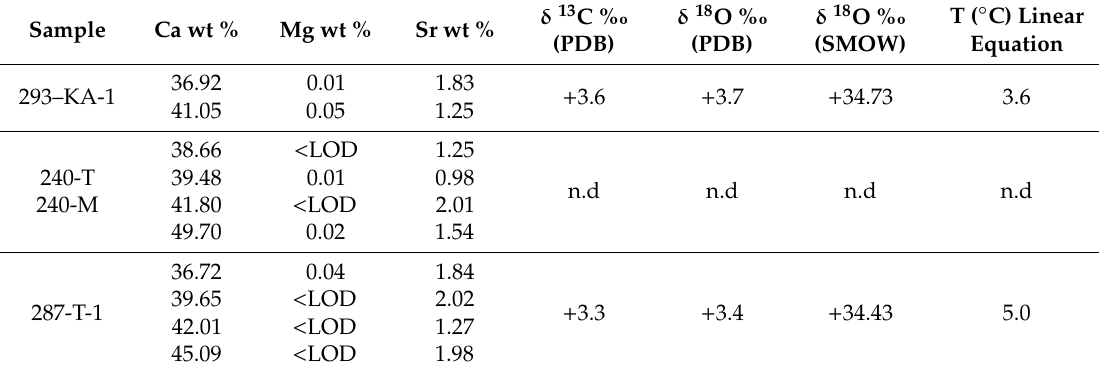
Table 9. Concentration of Ca, Mg, Sr and isotopic composition of aragonite with temperatures calculated based on this data.